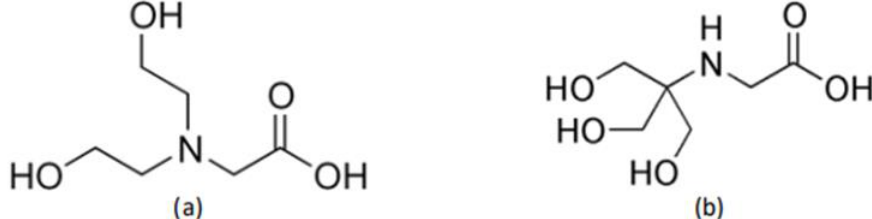
Figure 1. Chemical structure of bicine ( a ) and tricine ( b ).